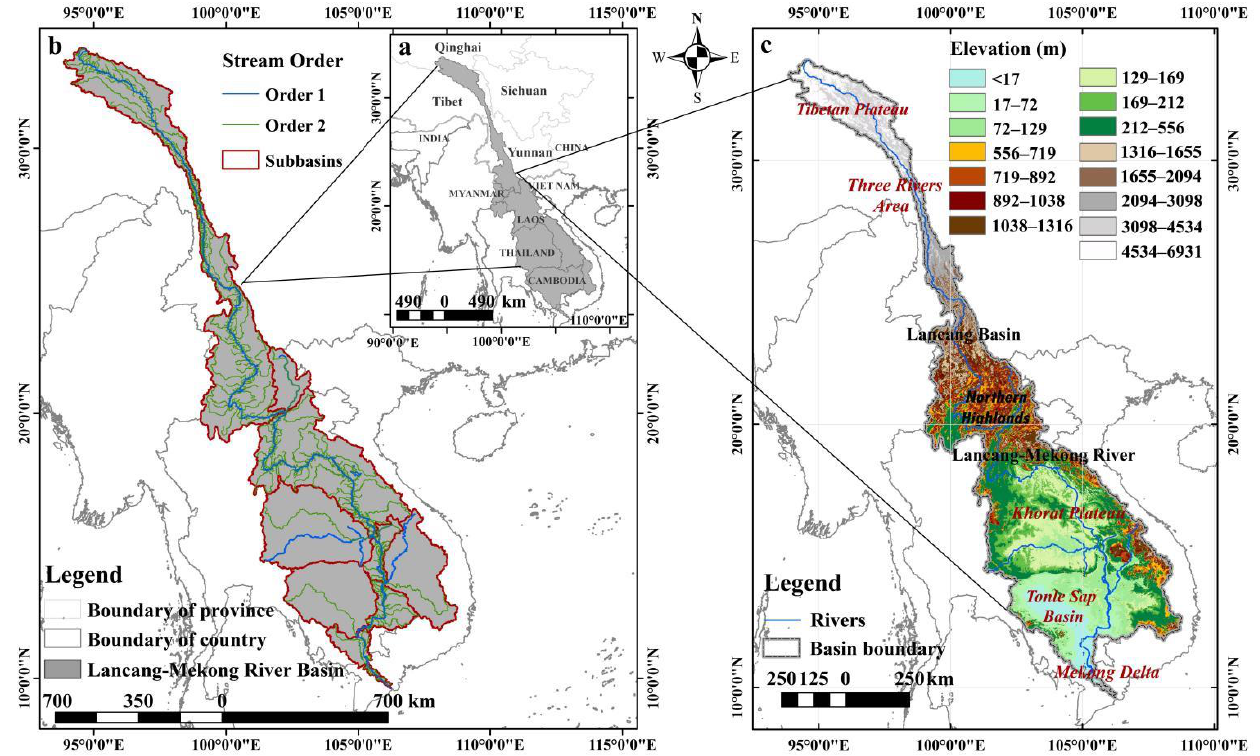
Figure 1. Lancang-Mekong River Basin. ( a ) Geographical location; ( b ) river network; ( c ) elevation.